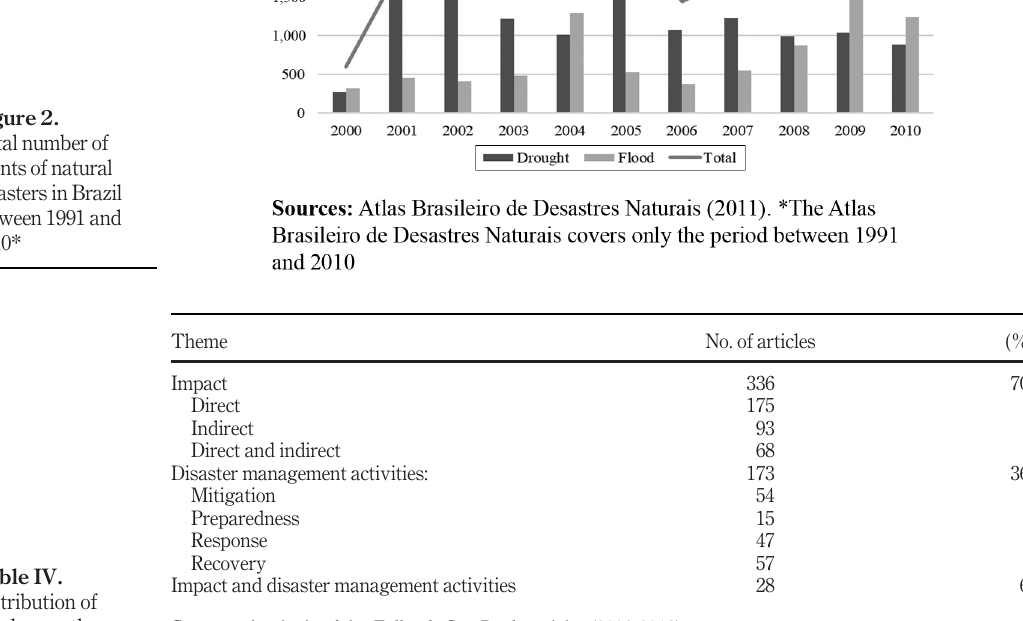
Table IV. Distribution of articles per theme